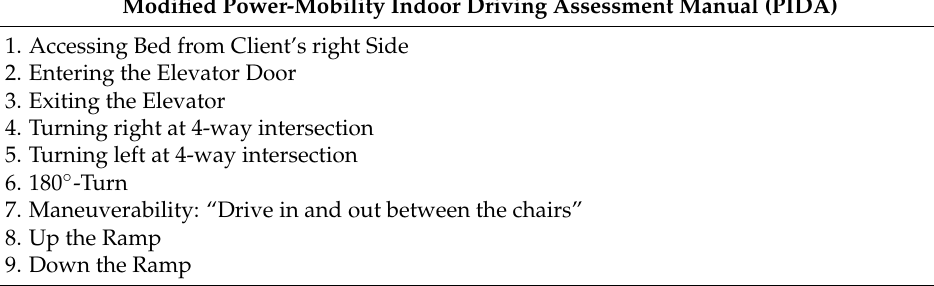
Table 1. Modified Power-Mobility Indoor Driving Assessment Manual